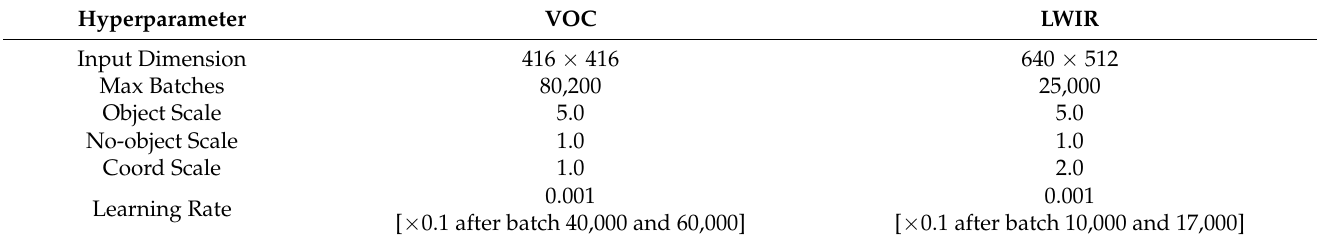
Table 6. Modified hyperparameters for LWIR training. Any parameter that is not listed here is the same as for the VOC training.